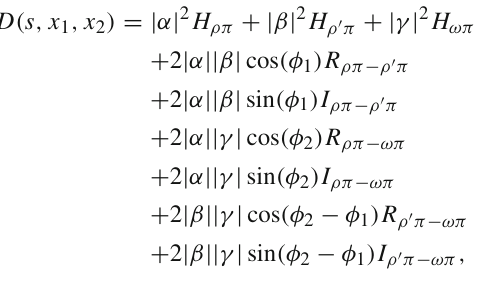
ρ( 1700 )π state is suppressed by the phase space compared to the ρ( 1450 )π . This suppression is by a factor of about 3 in the the ω( 1650 ) energy range and grows rapidly with decreasing